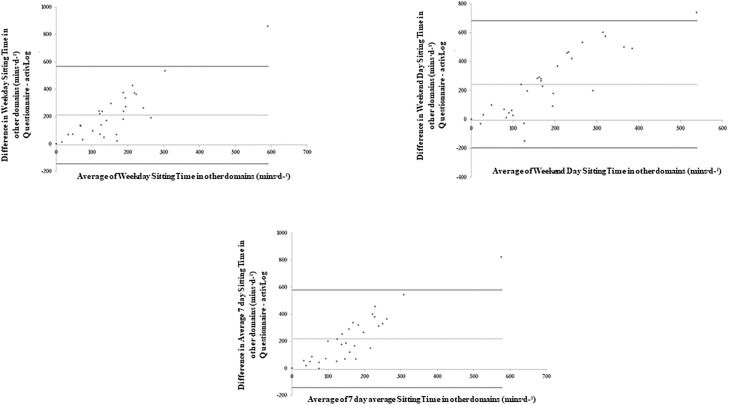
Bland-Altman plots of absolute agreement of sitting time in all other non-screen leisure domains (weekdays, weekend days and average of last 7 days) derived from the questionnaire with the equivalent variable derived from the criterion measure (combination of AP3M determined sedentary time and the domain specific log).